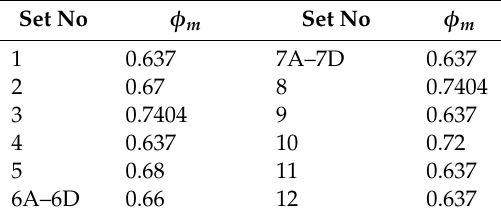
Table 5. Summary of φ m values used in the plotting of Figure 23.